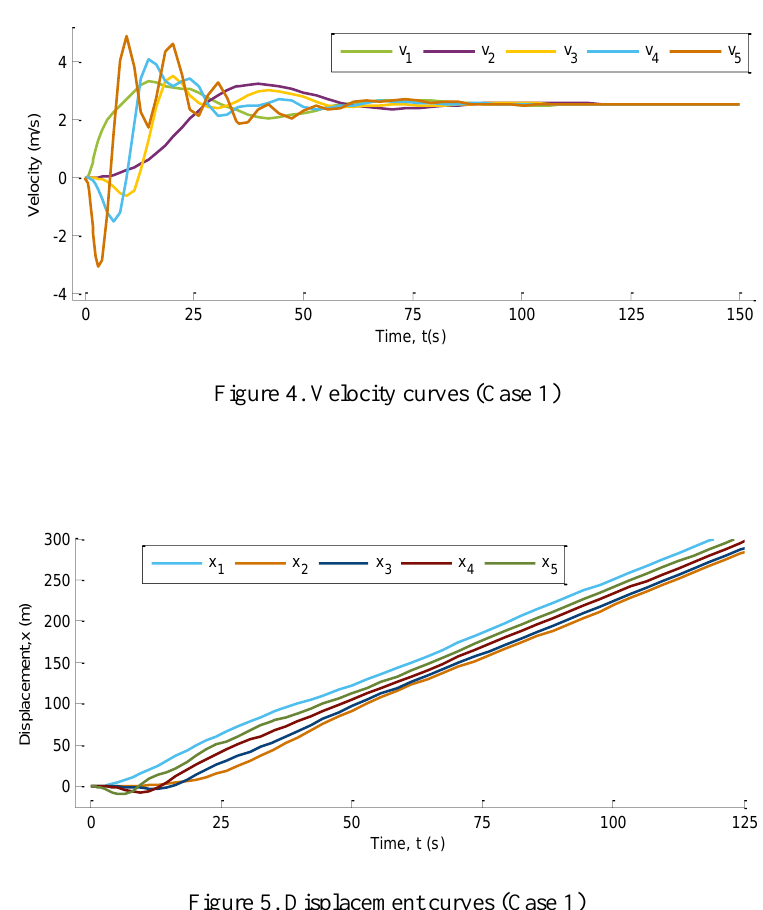
Figure 5. Displacement curves (Case